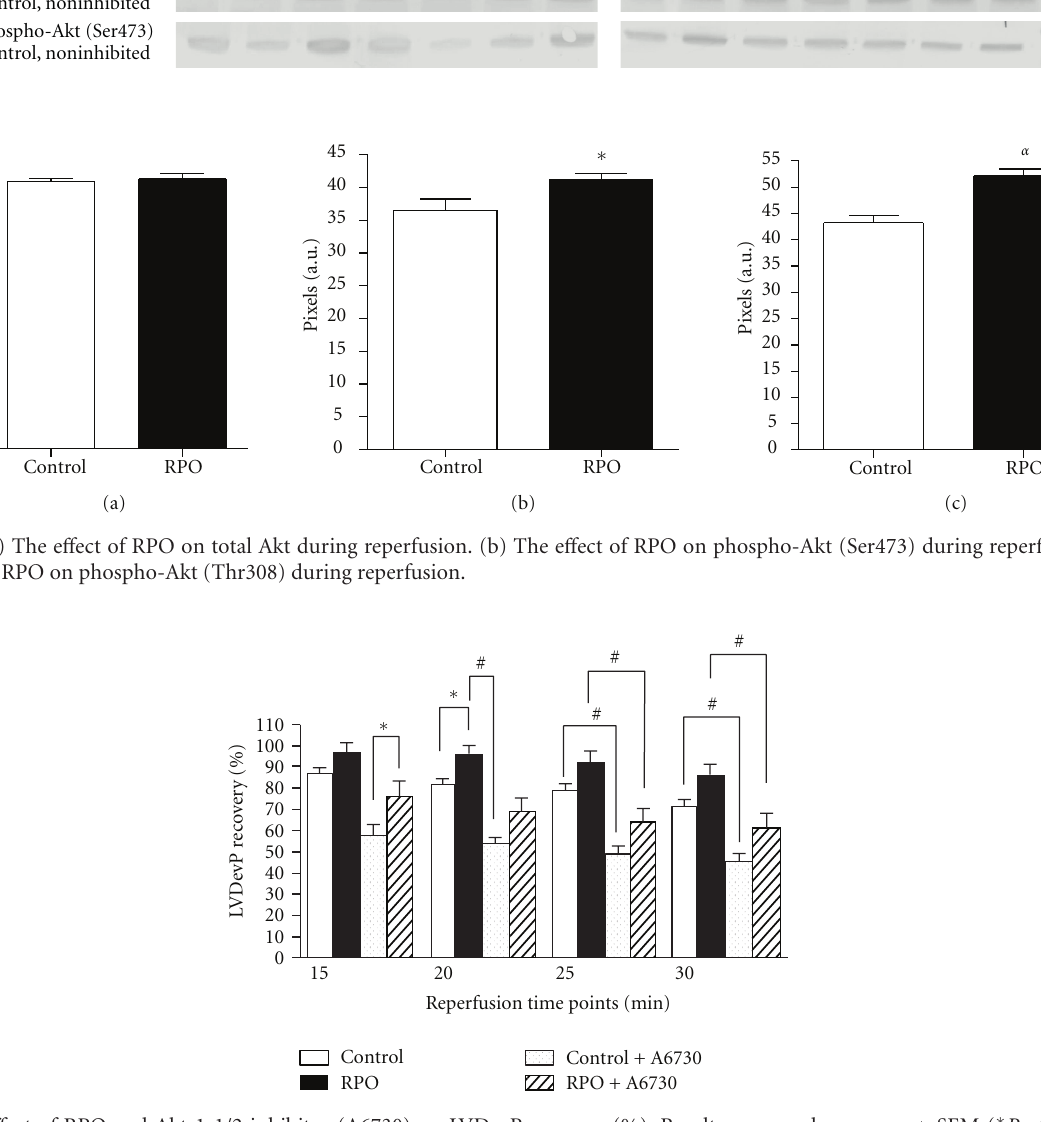
groups: control versus control + A6730 (49 . 24 ± 1 . 59 pixels versus 36 . 97 ± 1 . 95 pixels RPO; P < 0 . 01), RPO versus control + A6730 (49 . 81 ± 1 . 33 pixels versus 36 . 97 ± 1 . 95 pixels; P < 0 . 01) and RPO versus RPO + A6730 (49 . 81 ± 1 . 33 pixels versus 34 . 18 ± 1 . 22 pixels; P < 0 . 01) (Figure 6(a)).